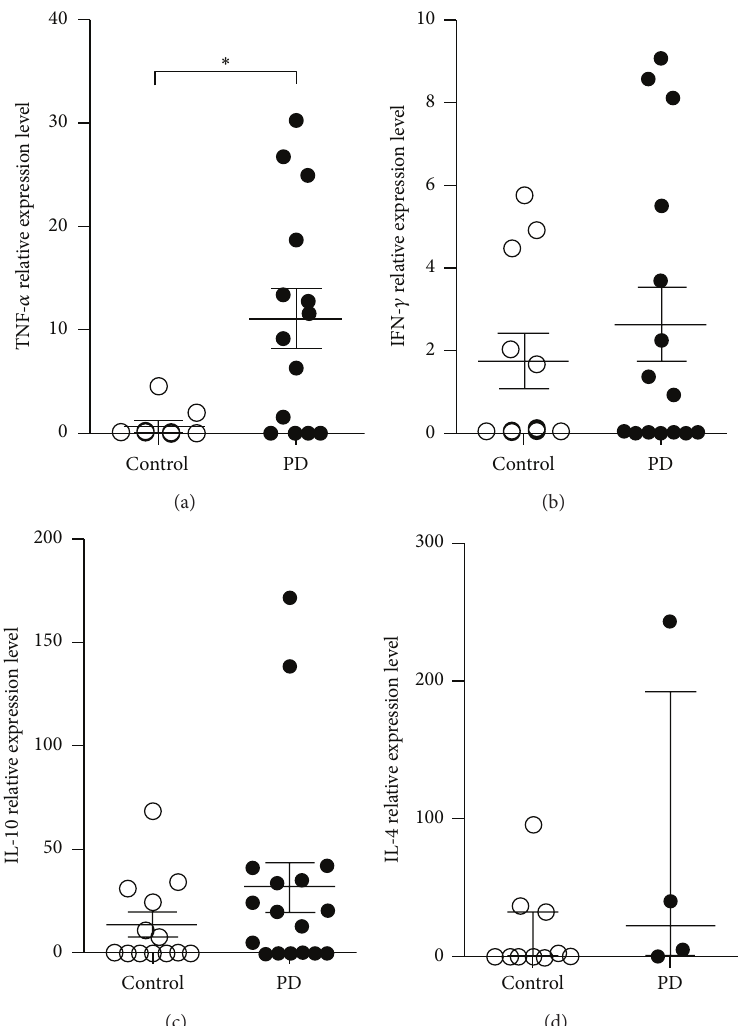
Figure 2: Cytokine expression in alveolar bone tissue of control and periodontal disease (PD) patients. Total RNA extracted from bone biopsies of PD and control group was subjected to qRT-PCR, SYBR green method. RNA expression of TNF- 𝛼 (a), IFN- 𝛾 (b), IL-10 (c), and IL-4 (d) is presented as the intensity of expression of the individual mRNAs, with normalization to 𝛽 -actin, using the cycle threshold method. Data are the mean ± SEM results for patients with PD and control subjects tested individually. The results shown are from one experiment representative of three. ∗ 𝑝 < 0.05